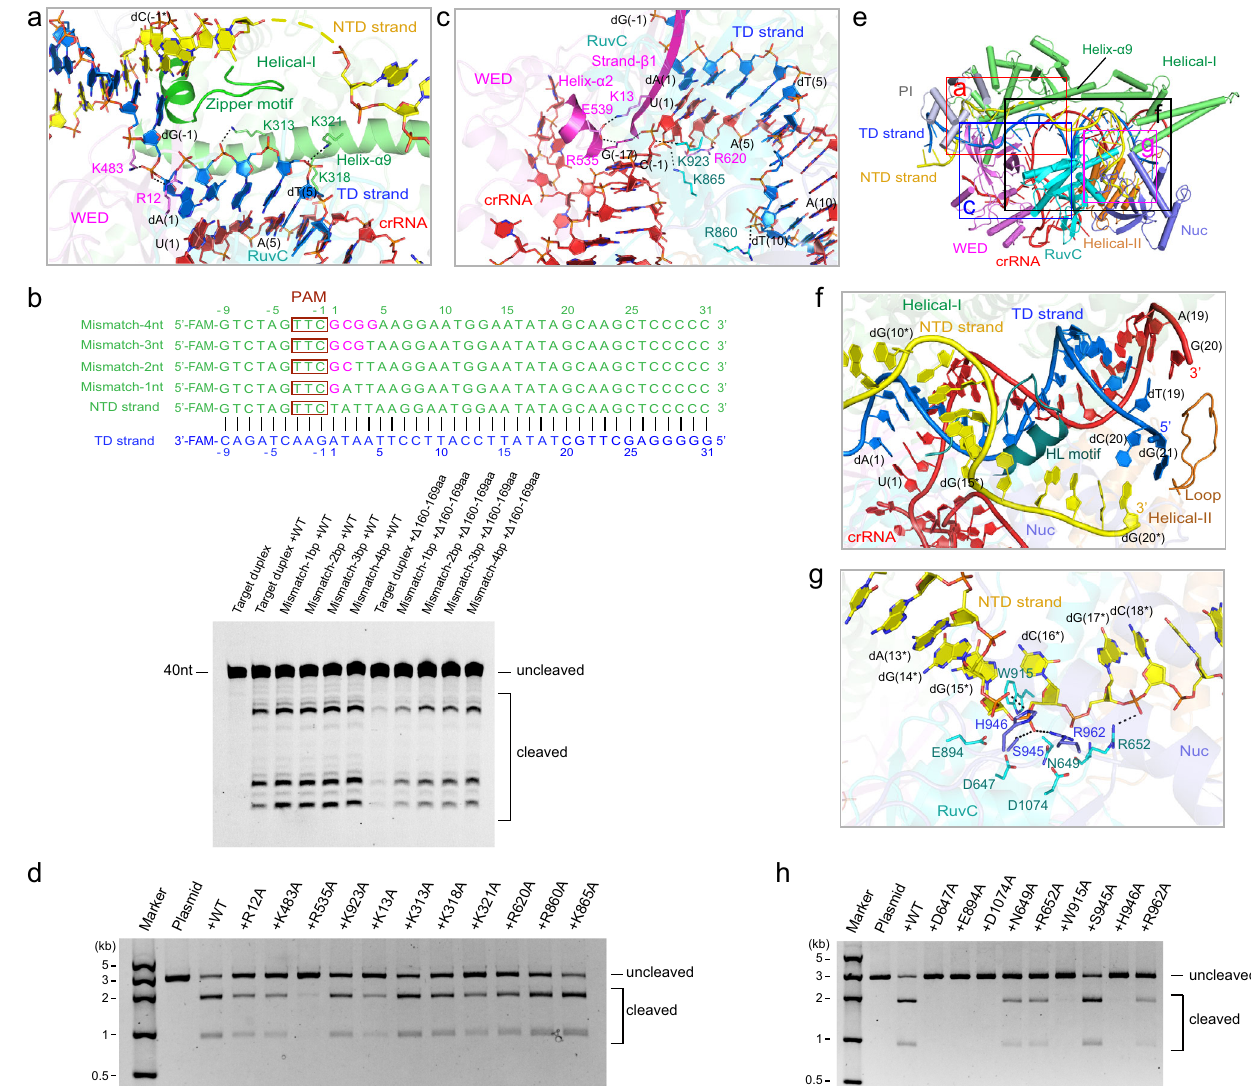
Fig. 3 The target duplex unwinding and R-loop formation. a Detailed interactions between the unzipped target duplex and Cas12i1 at the PAM-proximal region of the Cas12i1 pre-cleavage R-loop complex. The zipper motif (residues 160 – 177aa) facilitates unwinding of the target duplex. b Schematic representations of the fl uorescently labeled target duplex and 1 – 4-nt mismatched NTD strands designed to form 1 – 4-bp mismatched duplexes. Denaturing gel demonstrating the cleavage of the fl uorescently labeled target duplex or mismatched duplexes by wild-type Cas12i1 and the △ 160 – 169aa mutant in complex with crRNA. c Detailed interactions between the PAM-proximal region of the heteroduplex and Cas12i1. d Agarose gel demonstrating the cleavage of the linearized plasmid by wild-type Cas12i1 and the mutants in complex with crRNA. e The relative positions of ( a ), ( c ), ( f ), and ( g ) in the Cas12i1 pre- cleavage R-loop complex. The long helix α 9 of the Helical-I domain is labeled. f The PAM-distal region of the R-loop structure. The HL motif (residues 895 – 915aa) of the RuvC domain is located between the crRNA guide region-TD strand heteroduplex and the unpaired NTD strand. A loop region of the Helical-II domain helps the TD strand interacting with the NTD strand. g Detailed interactions between the unpaired NTD strand and the RuvC catalytic pocket of Cas12i1. Residue A647 of the catalytically inactive Cas12i1 pre-cleavage R-loop complex was virtually mutated back to D647. h Agarose gel demonstrating the cleavage of the linearized plasmid by wild-type Cas12i1 and the mutants related to the RuvC catalytic pocket in complex with crRNA. The cleavage assays of ( b ), ( d ), and ( h ) were repeated three times independently to con fi rm the repeatability, respectively, and source data are provided as a Source data fi